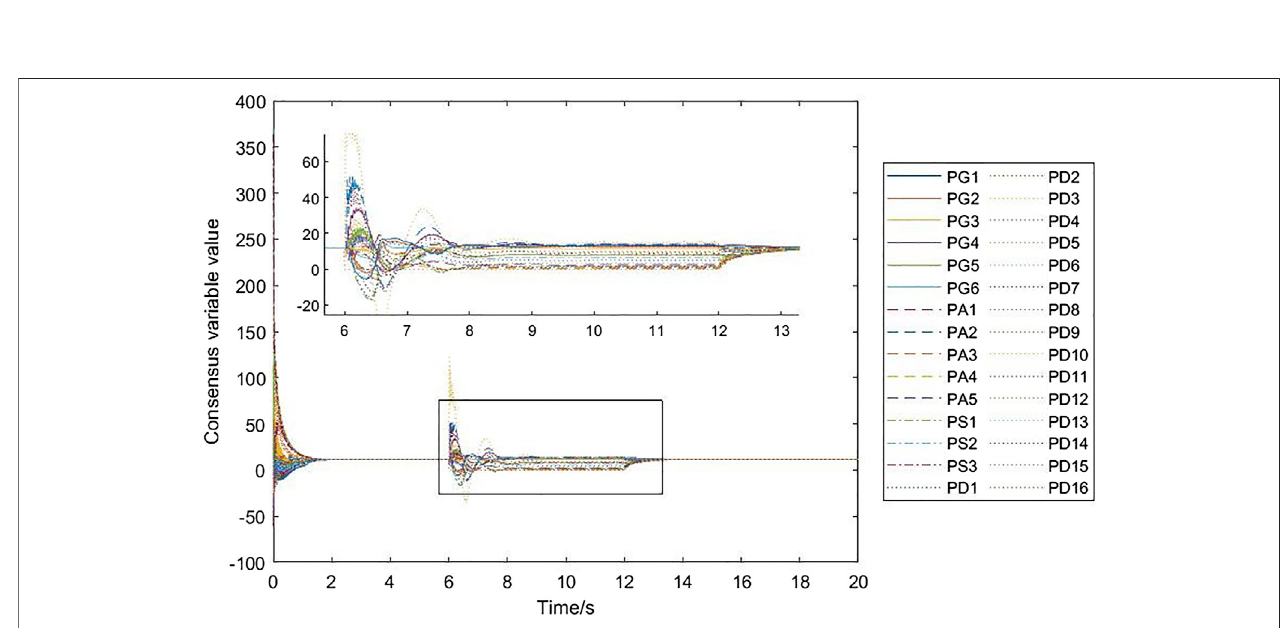
FIGURE 6 | Simulation results of consensus